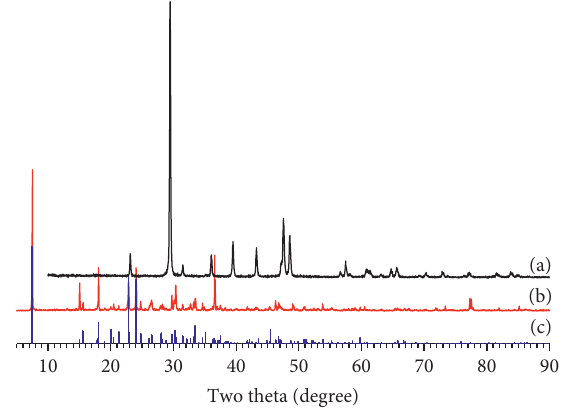
Figure 1: The XRD powder patterns of oyster shell (a), synthesized product (b), and the simulated one of Ca(H 2 PO 4 ).H 2 O (c, JCPDS No. 71-0656) represented by the vertical bars, adapted from [14].